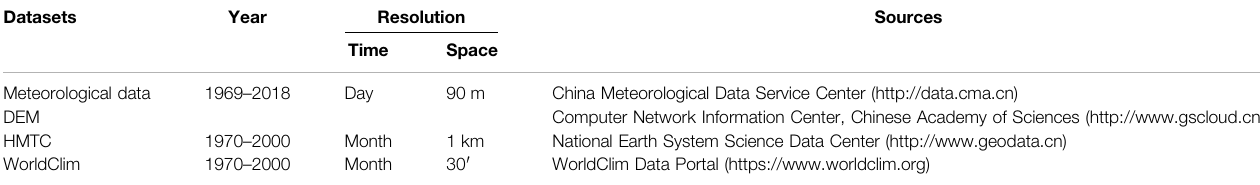
TABLE 1 | Datasets used to analyze NSAT in Southwest China.